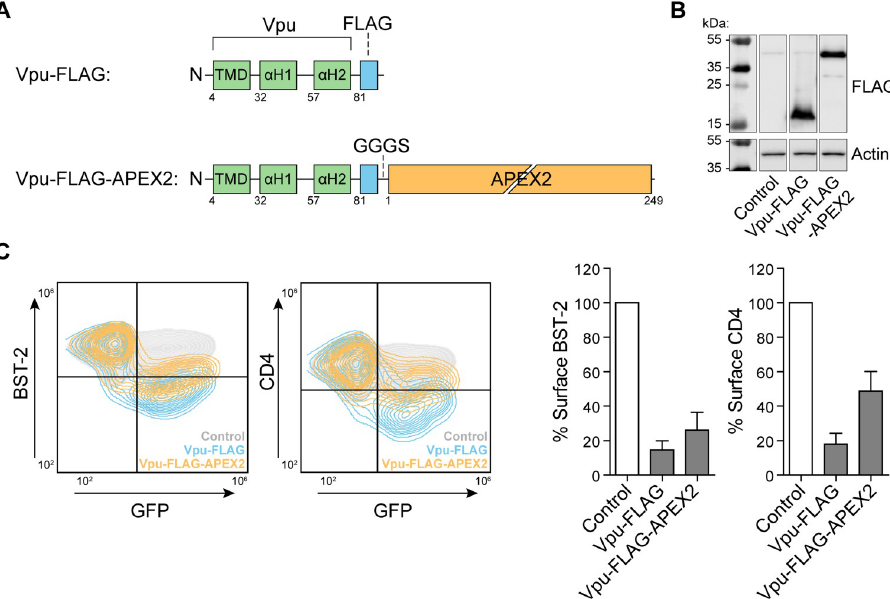
Fig 1. Vpu-APEX2 fusion protein design and activity. (A) A schematic representation of C-terminally tagged Vpu constructs; Vpu-FLAG and Vpu-FLAG-APEX2. A GGGS linker lies between the FLAG epitope and APEX2. (B) HeLa P4.R5 cells were transfected with Vpu constructs bearing C-terminal FLAG or FLAG and APEX2. Protein expression was analysed by western blot. (C) Cell-surface levels of BST-2 and CD4 were measured in the presence of Vpu-FLAG or Vpu-FLAG-APEX2 by flow cytometry. Representative two-color flow plots are shown, GFP was used as a marker for transfection. Surface levels of BST-2 and CD4 on cells expressing FLAG- or FLAG-APEX2-tagged Vpu was expressed as the % of control cells not expressing Vpu. Error bars represent standard deviation of n = 3 experiments.